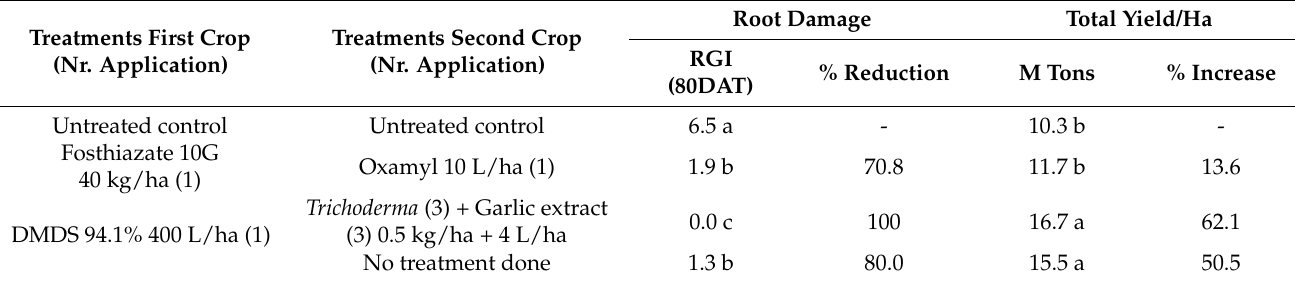
Table 4. Efficacy of DMDS alone and its strategies with biopesticides in controlling the root-knot nematode ( M. arenaria ) in second crop cucumber in the same plots and greenhouse. Spring–summer cycle (April–July 2019). Treatments First Crop